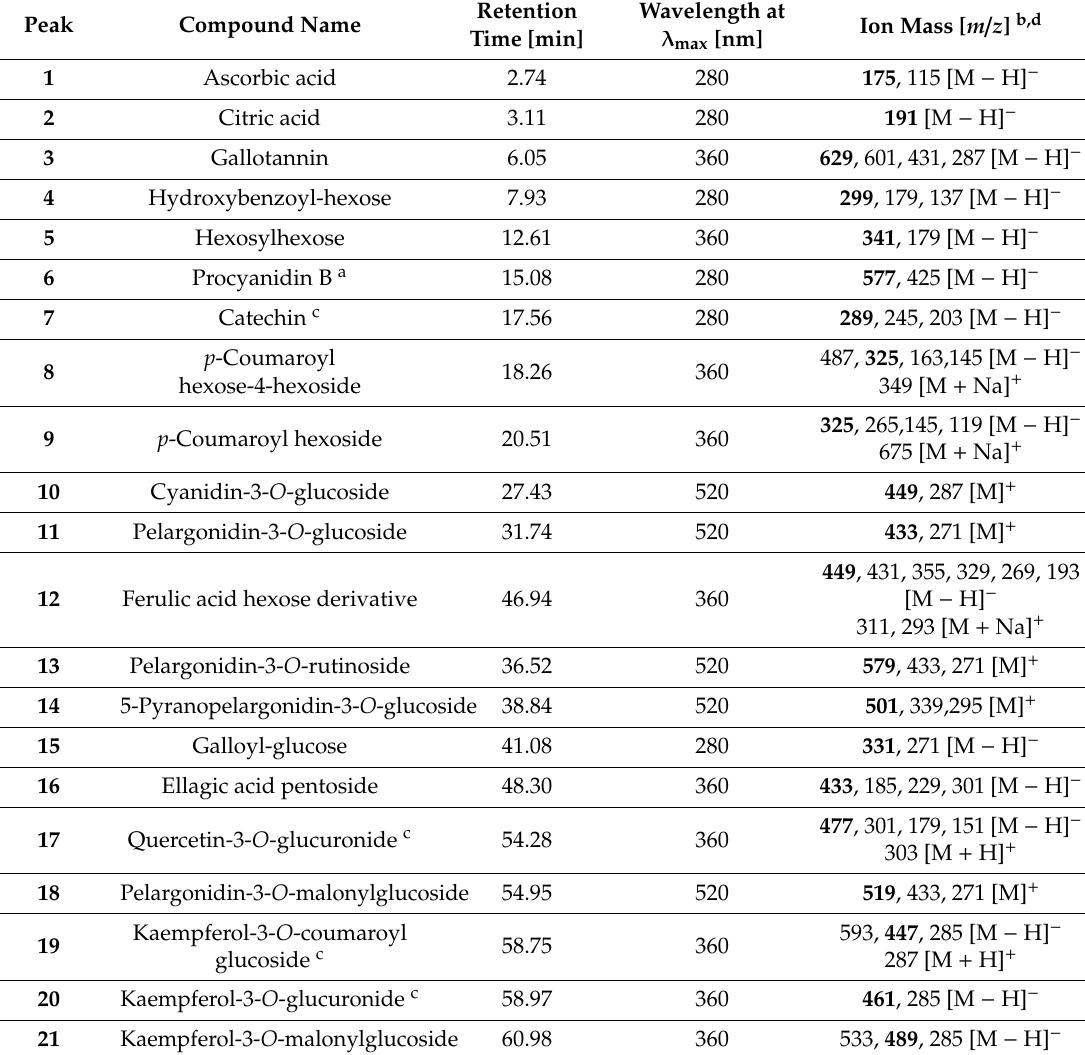
Table 1. Identified compounds in strawberry ( Fragaria × ananassa ‘Nerina’)